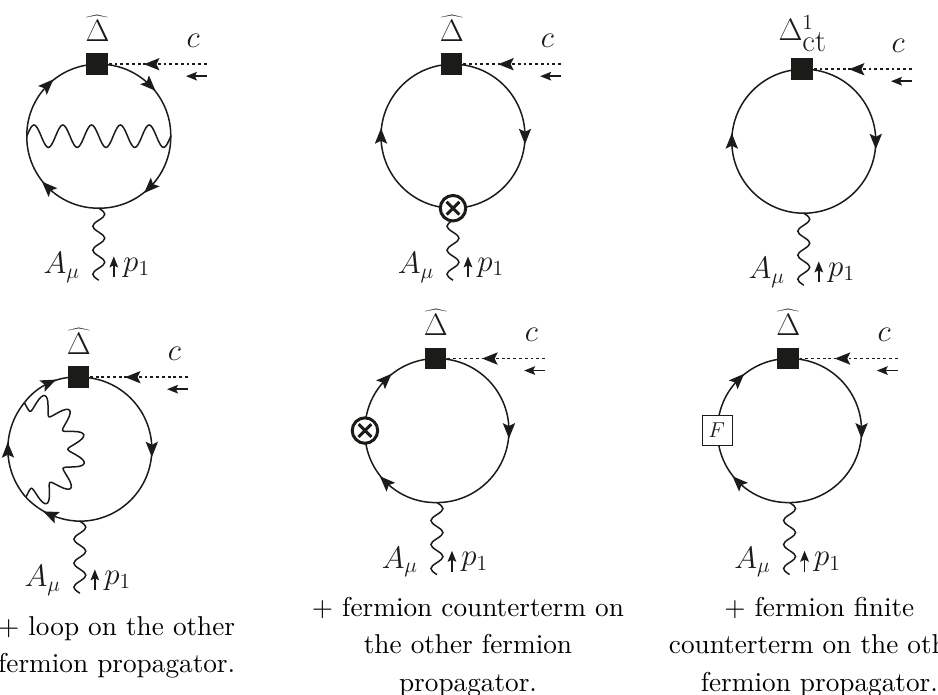
Figure 2 . List of Feynman diagrams for the ghost-photon breaking contribution given in eq. (8.4). The diagrams in the first column are genuine two-loop diagrams with one insertion of the tree-level breaking b ∆ . The diagrams in the second column are one-loop diagrams with one insertion of a one-loop singular counterterm, denoted as a circled cross. The third column contains a one-loop diagram with an insertion of a one-loop symmetry-restoring counterterm, denoted by a boxed F , and a one-loop diagram with an insertion of the one-loop breaking ∆ 1 ct